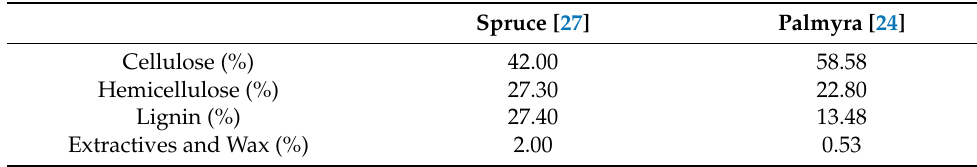
Table 1. Chemical composition of spruce and palmyra